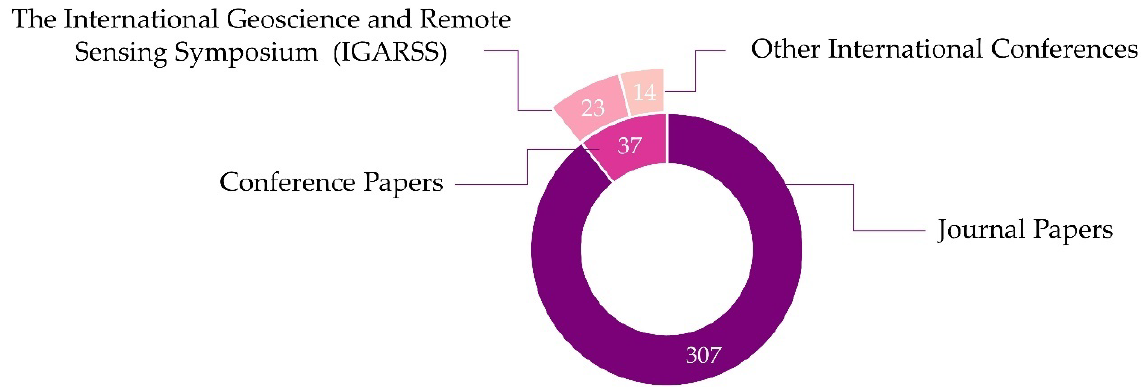
Figure 6. The number of journal and conference publications included in the meta-analysis.